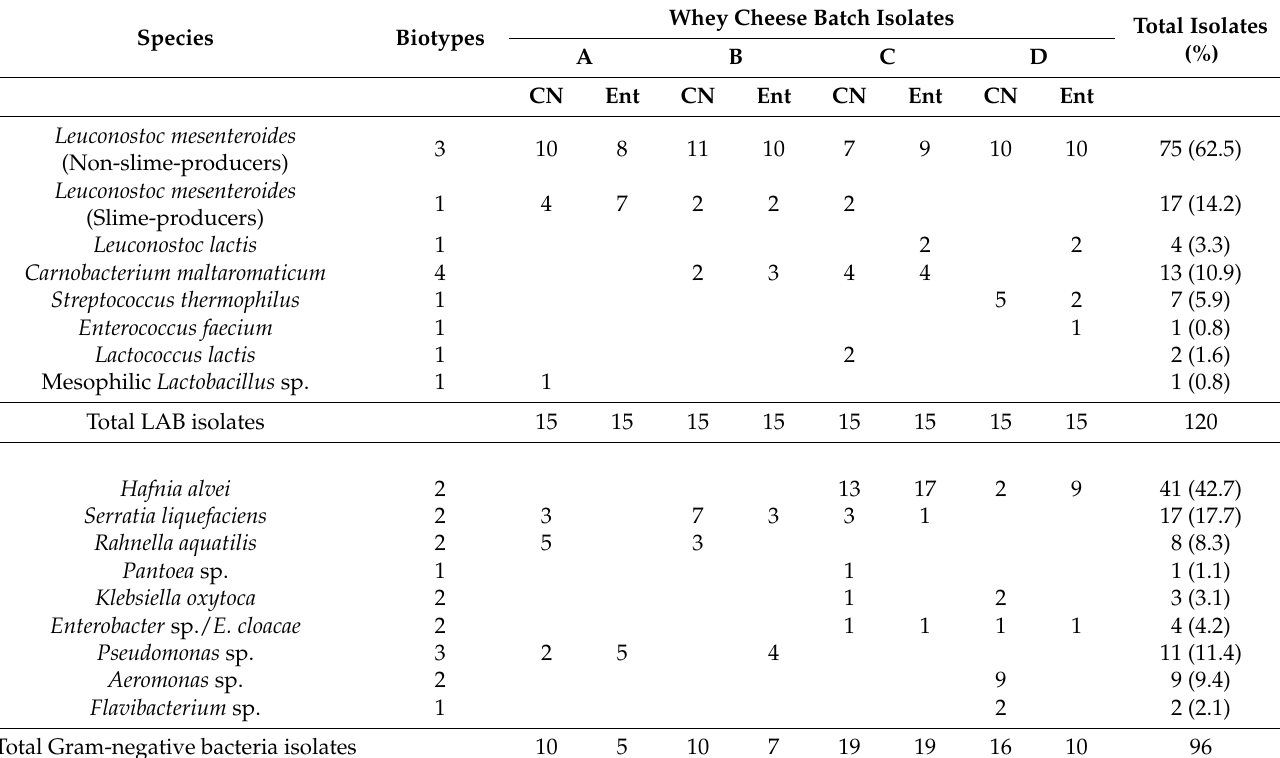
Table 2. Overview of the terminal spoilage association in four batches (A, B, C and D) of fresh Anthotyros whey cheese without (CN) or with 5% crude enterocin A-B-P extract (Ent) after 30 to 40 days of vacuum-packaged storage at 4 ◦ C (data adapted from Sameli et al. [37] were